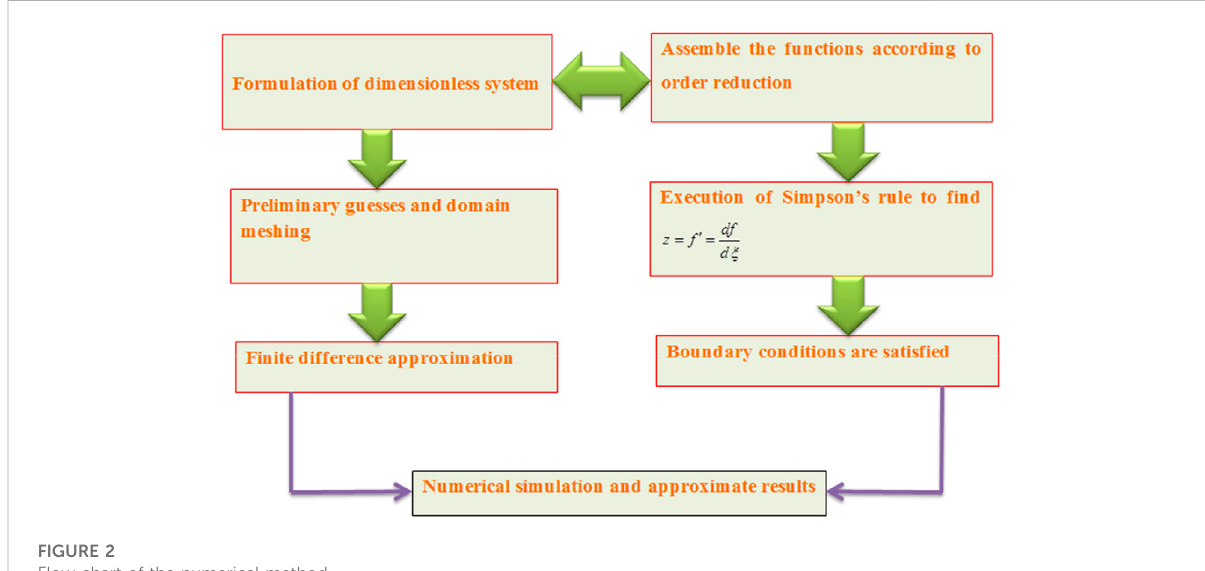
FIGURE 2 Flow chart of the numerical method.